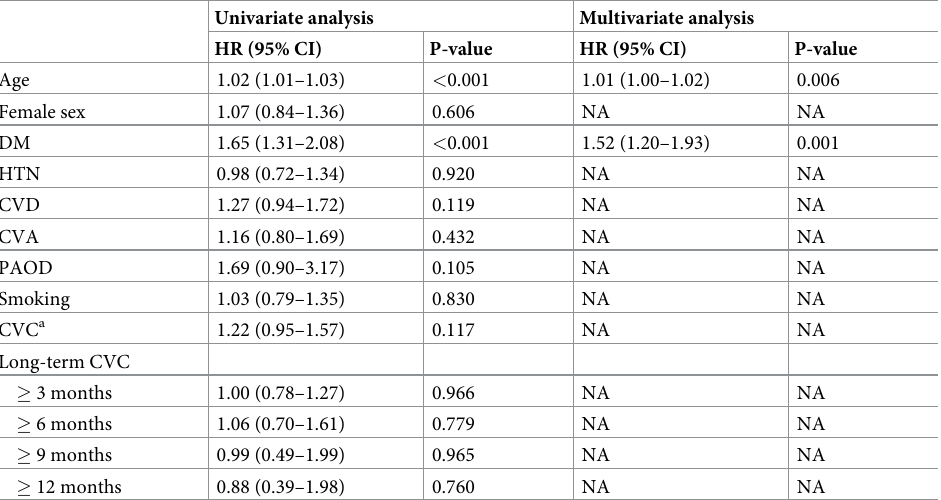
Table 2. Factors associated with primary patency in the study population.